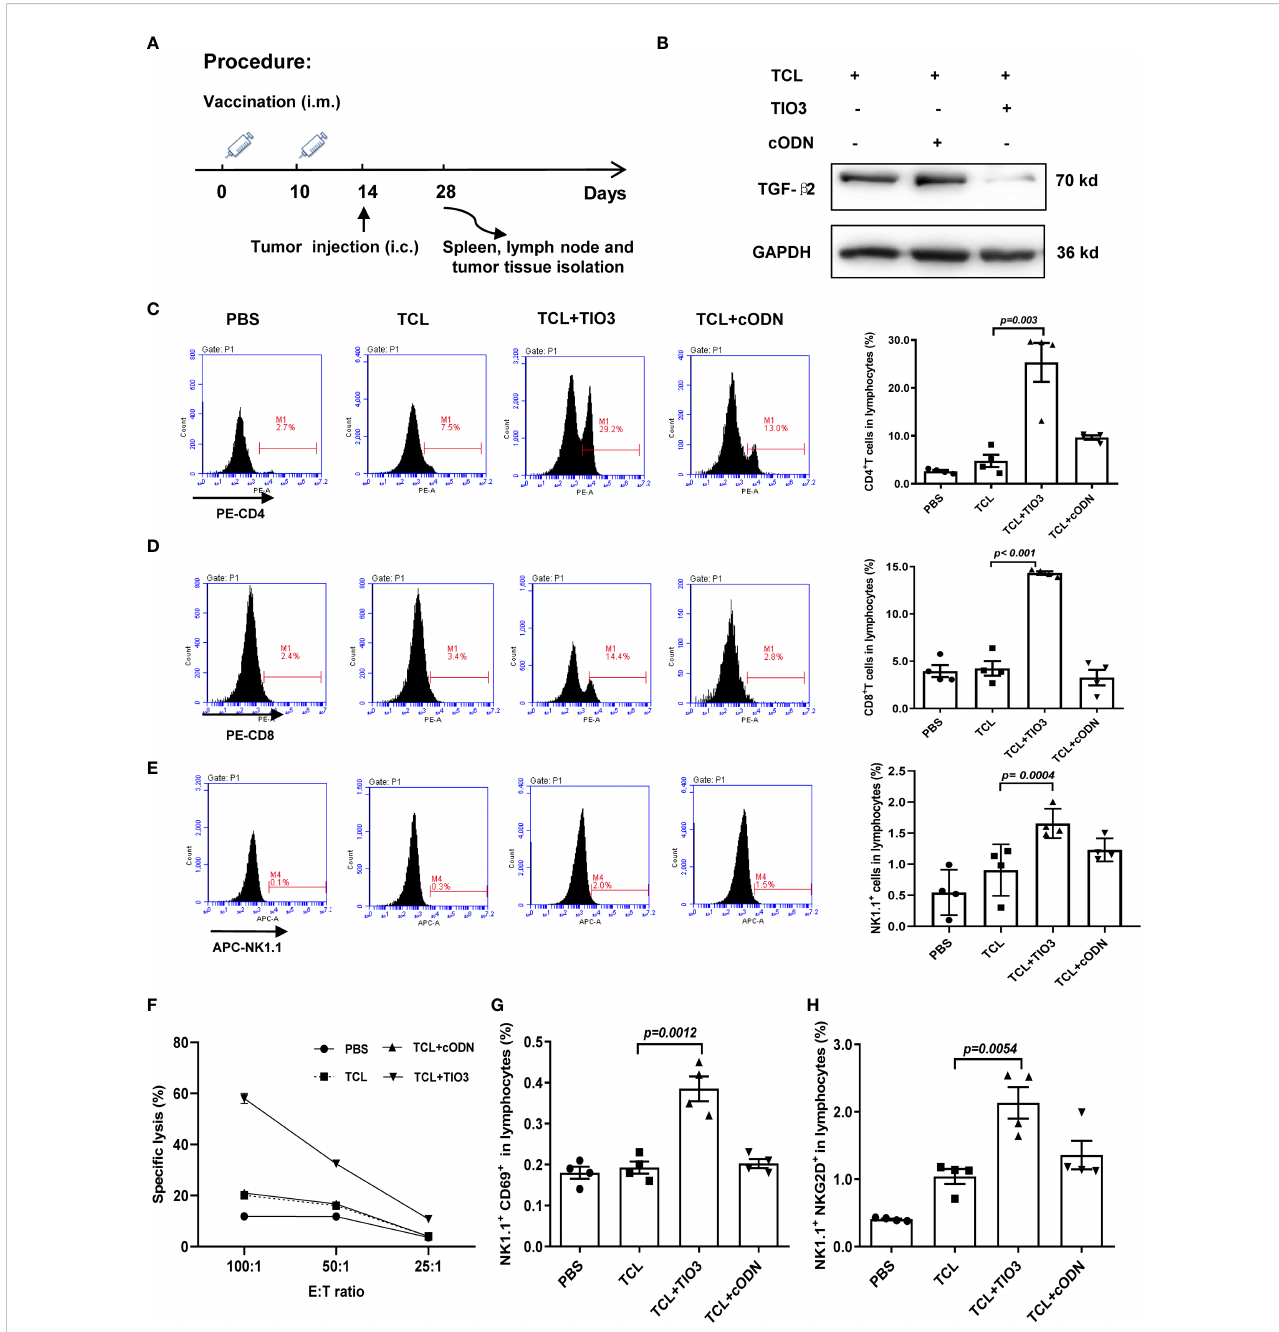
FIGURE 5 Effect of TCL+TIO3 on the activation of cytotoxic T lymphocytes and NK cell in glioma-bearing mice. The mice (n=4) were intramuscularly immunized with PBS, TCL, TCL+TIO3 and TCL + cODN in the neck on day 0 and 10, and then and then challenged i.c. with 2×10 4 GL261 cells on day 14. 4 mice were sacri fi ced on day 28. (A) Experimental procedure. (B) TGF- b 2 expression in glioma tissue isolated from the mice on day 28 by western blotting. (C-E) Percentages of CD4 + T, CD8 + T and NK cells in lymph nodes. (F) Glioma-speci fi c CTL detection. Splenocytes were co-cultured with GL261 cells for 8 h at effector/target ratios of